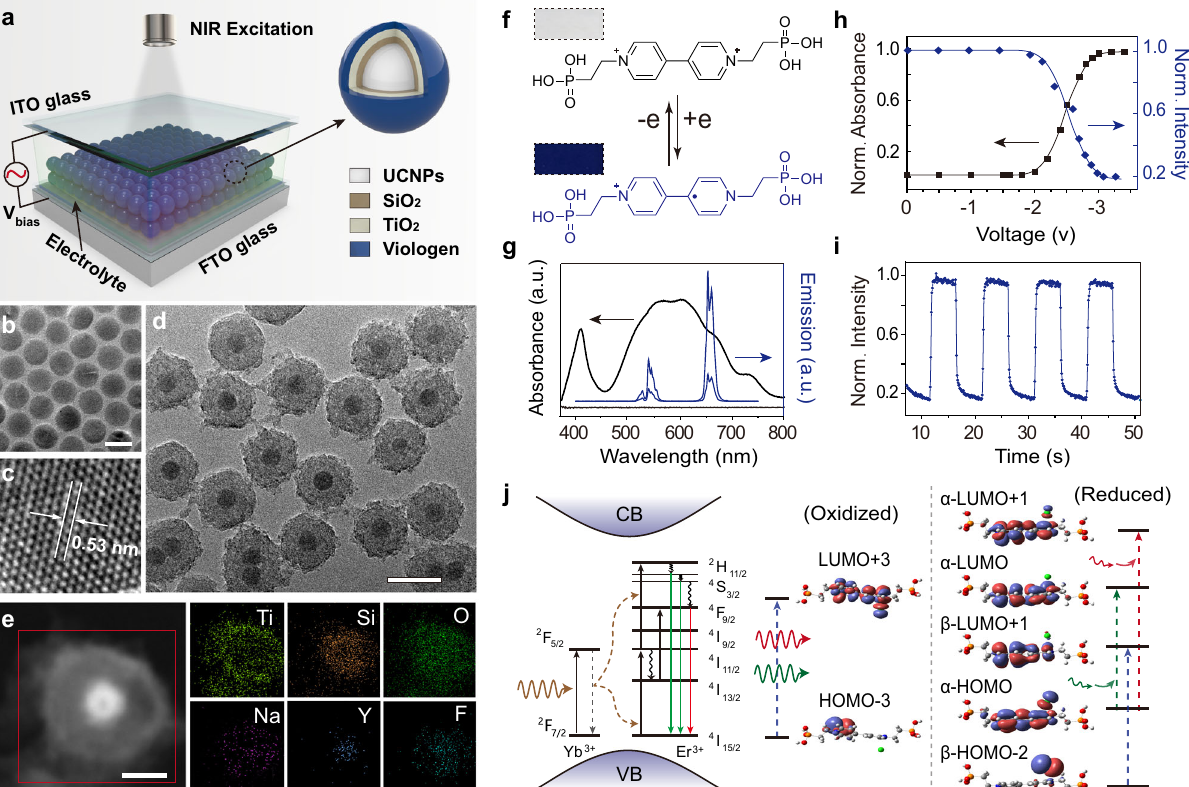
Fig. 2 Experimental demonstration of electrically switchable upconversion luminescence. a Schematic of an electrochemical cell based on viologen molecule-modi fi ed UCNPs. b , c Representative TEM images of NaYF 4 :Yb/Er nanoparticles under study. Scale bar: 20nm. d , e TEM images of NaYF 4 :Yb/ Er@SiO 2 @TiO 2 nanoparticles and corresponding EDX elemental mapping of a single nanoparticle. Scale bar: 50nm for d and 20nm for e . f Chemical structures of 1,1 ’ -bis(2-phosphonoethyl)-4,4 ’ -bipyridinium dichloride (PV) in oxidised and reduced forms. Insets show optical images of the oxidised and reduced PV molecule, respectively. g Absorption spectra of PV molecules of a hybrid fi lm in oxidised and reduced states (black) and emission spectra of the hybrid fi lm in “ bright ” and “ dark ” states (blue). h Normalised absorption intensity of PV molecules of a hybrid fi lm at 654nm (black) and normalised upconversion emission intensity at 654nm (blue) as a function of the applied potential. i Reversible luminescence on/off cycles, recorded at 654nm under alternating applied potential (±3V). j Simpli fi ed energy level diagram of NaYF 4 :Yb/Er nanoparticles and the proposed mechanism underlying the opto-electrochemical